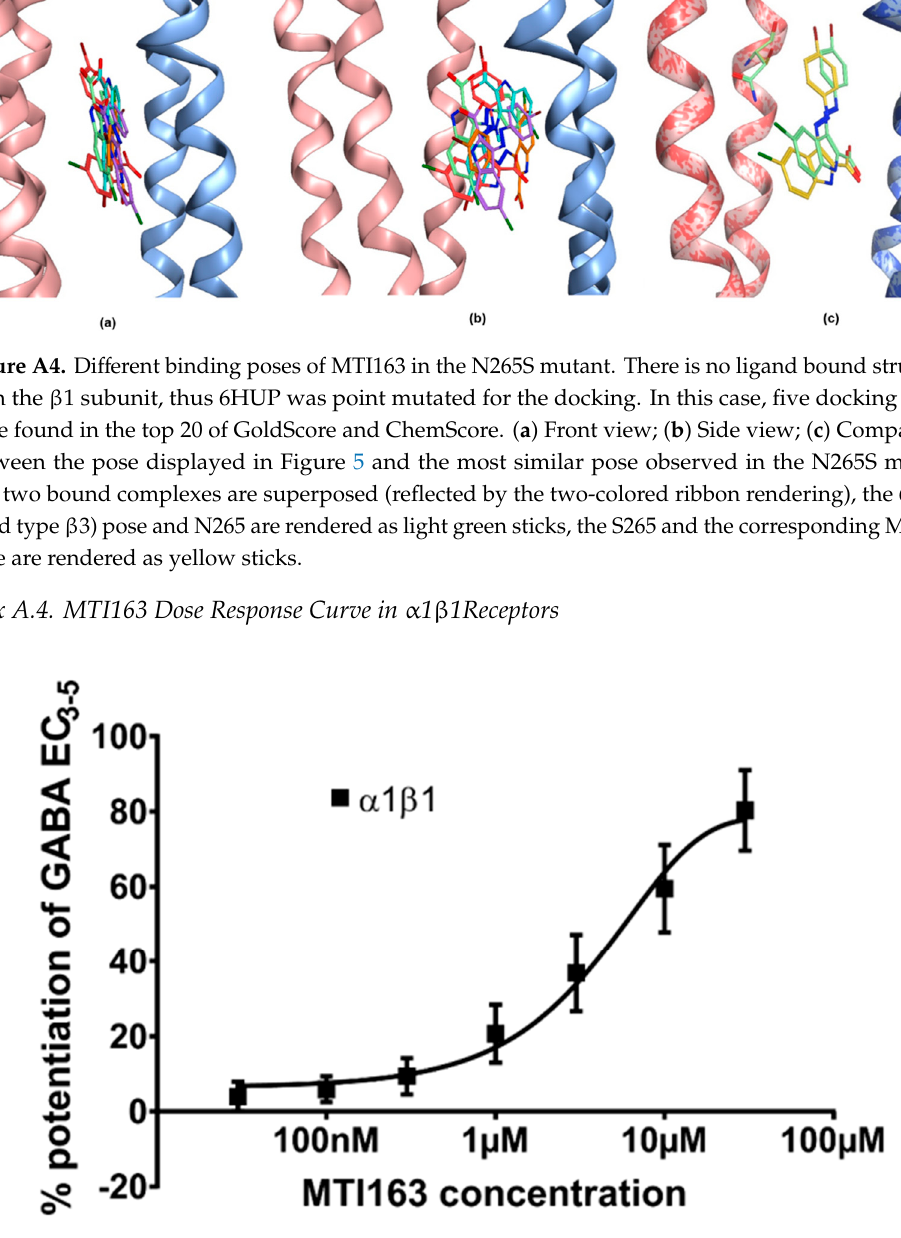
Figure A5. Concentration-dependent MTI163 modulation of GABA EC 3–5 elicited current in α 1 β 1. Response at each point of measurement is represented as individual data point as Mean ± SEM ( n = 4, EC 50 = 7.65 µM, nH = 0.78).